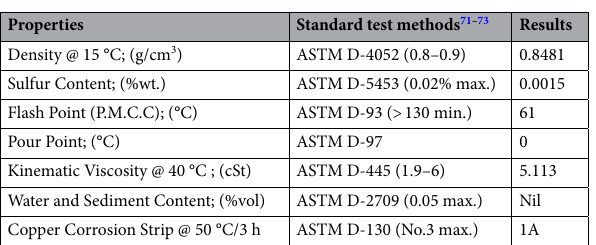
Table 7. Physical and Chemical Properties of Biofuels (Biodiesel) in Diesel Fraction Range (270–370 °C).